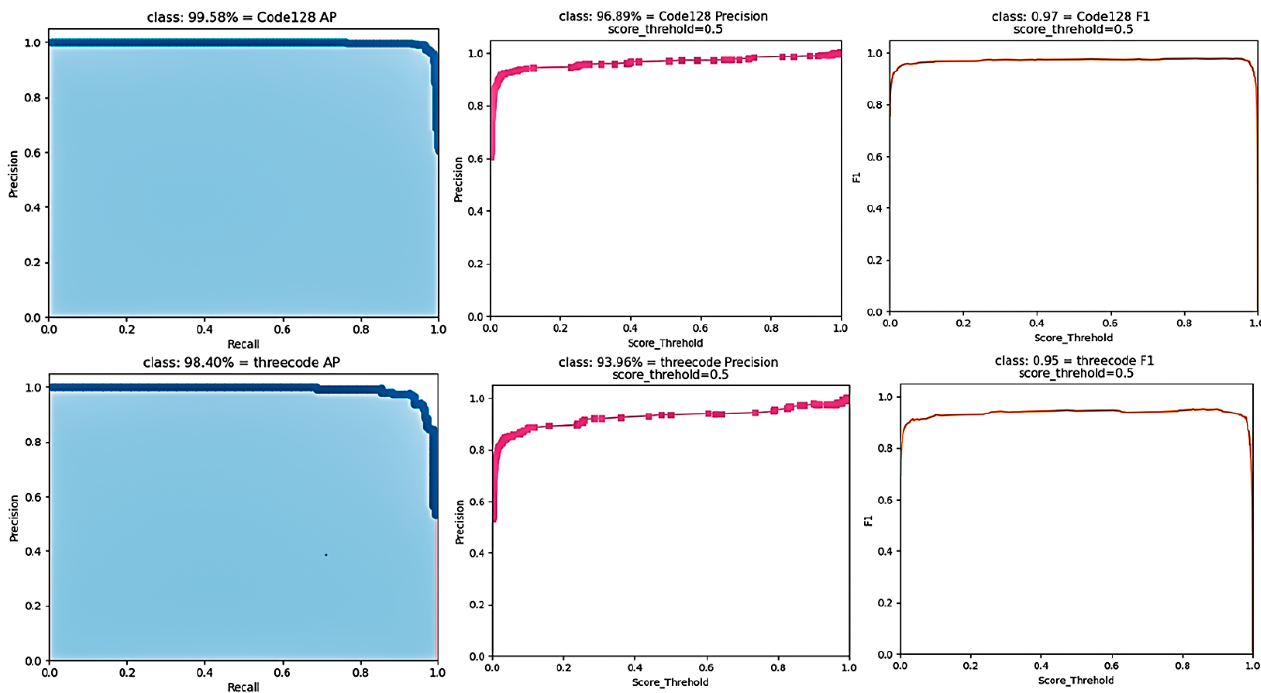
Figure 9. Model result diagram.